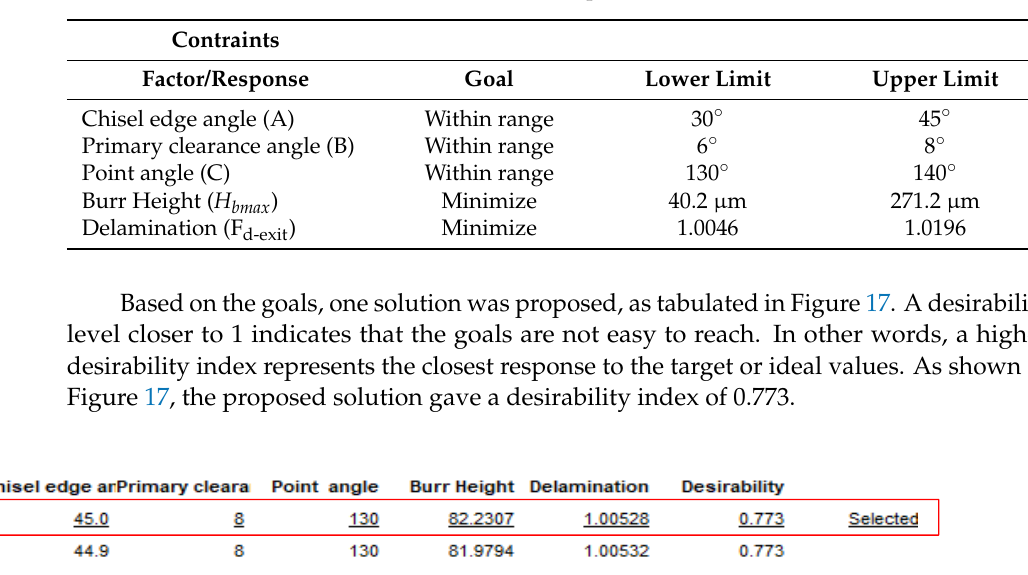
Table 6. Goals and constraints for the factors and responses.